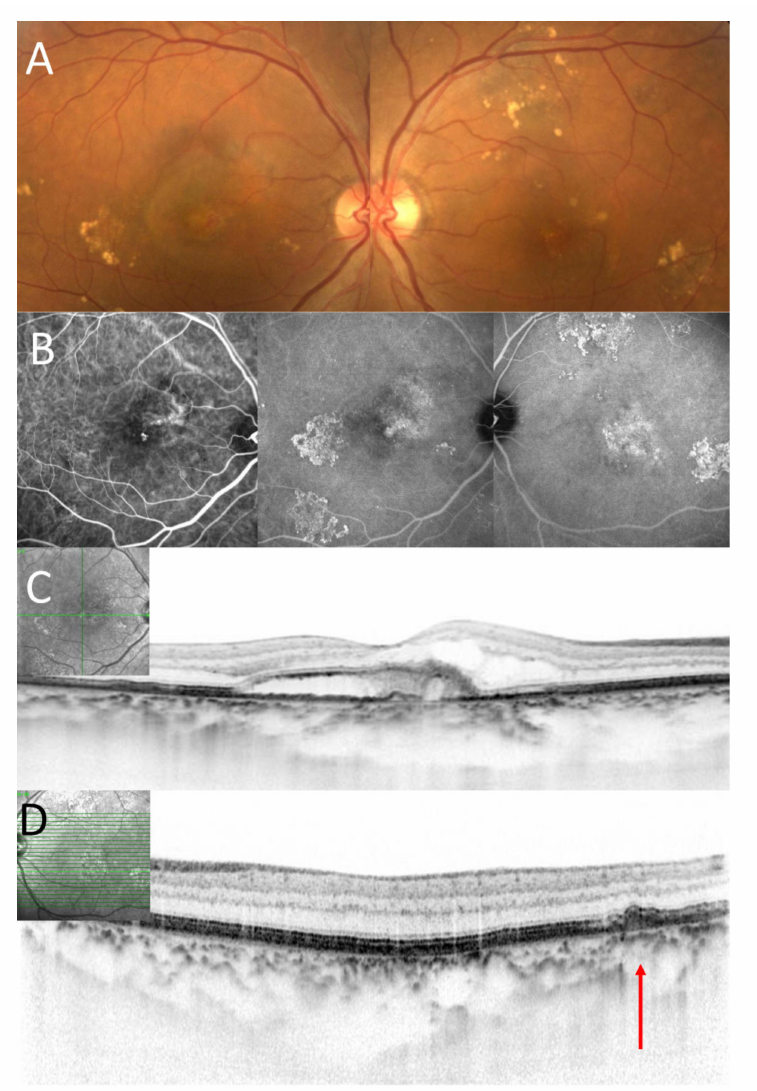
Figure 2. A seventy-three-year-old male patient with polypoidal choroidal vasculopathy. ( A ). Color fundus photography showed scattered yellowish drusenoid deposits around the macular in both eyes and exudation in the macular in the right eye. ( B ). On the early phase of ICGA, polypoidal lesion was seen in the macula in the right eye. (Left image). On the late phase of ICGA, hyperfluorescence was seen in the area corresponding to scattered yellowish drusenoid deposits in both eyes. (Middle and left image) ( C ). A horizontal OCT scan through the fovea showed exudation including subretinal fluid and fibrin in the right eye. Subfoveal choroidal thickness was 375 µ m in the right eye. ( D ). A horizontal OCT scan through the yellowish deposits showed drusenoid deposits (as indicated by a red arrow) in the left